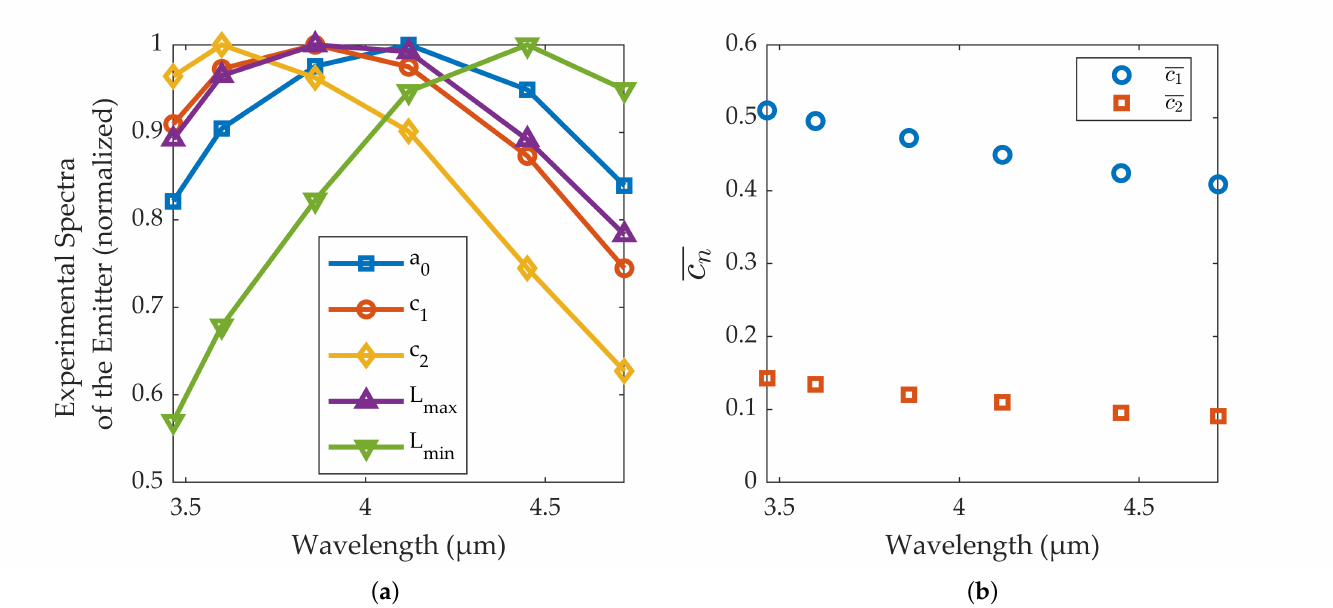
Figure 4. ( a ) Continuous part of the signal ( a 0 ), first and second harmonics ( c 1 and c 2 ), and maximum and minimum radiance of the emitter during each cycle ( L max and L min ), for each of the six filters used. ( b ) Amplitudes of the first two harmonics for each spectral band normalized to the DC